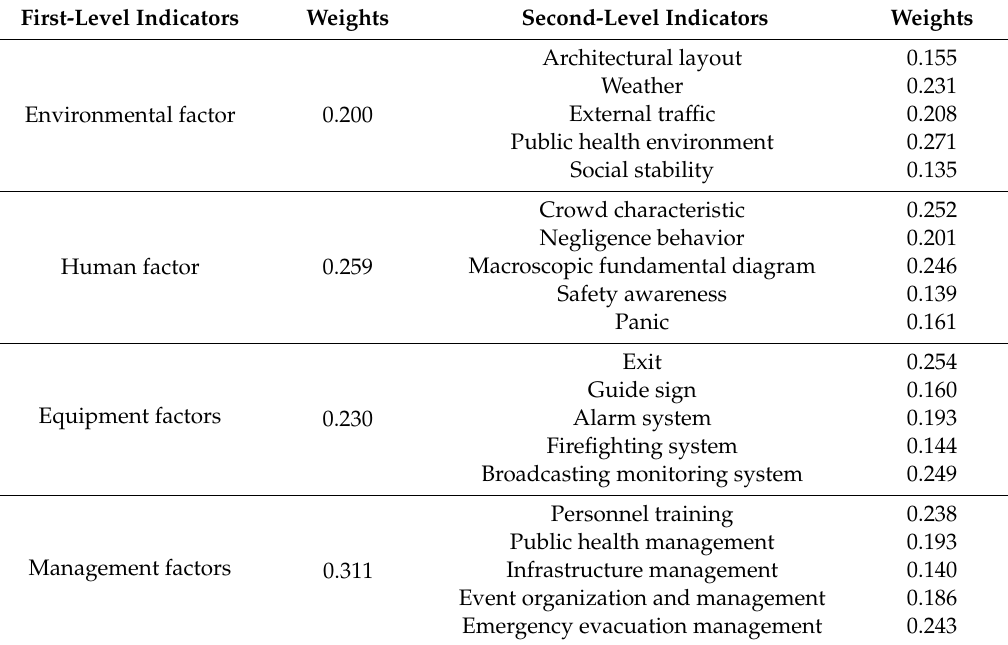
Table 4. Results of the weights of indicators in Tian-yi